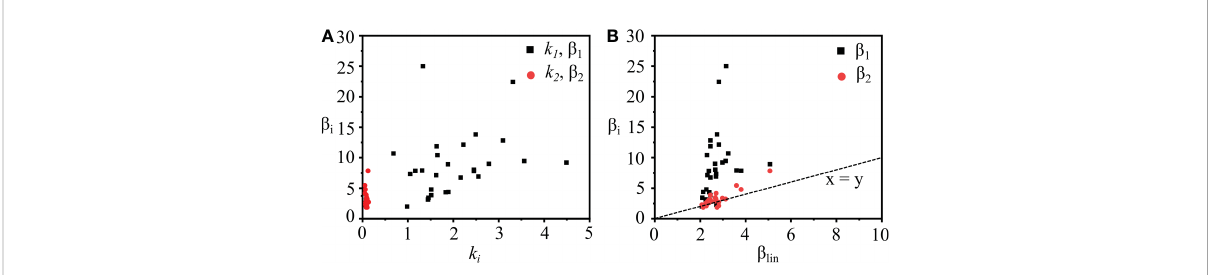
FIGURE 6 The plots show parameters ( b i , b l in , k i ) from the modeling results. (A) shows the relationship between the Si:Al ratio ( b i ) and the reactivity ( k i ) of the nonlinear dissolution Si fractions, the reactivity of the fi rst nonlinear fraction ( k 1 ) is higher than the second nonlinear fraction ( k 2 ). The range of b 1 (1 < b 1 < 25) is bigger than b 2 (2 < b 2 < 10). (B) shows the relationship of the Si:Al ratio between the two non-linear dissolving fractions ( b 1 , b b b b b b b 2 ) and lSi ( lin ). 1 is bigger than 2 and lin and 2 is approximately equal to lin